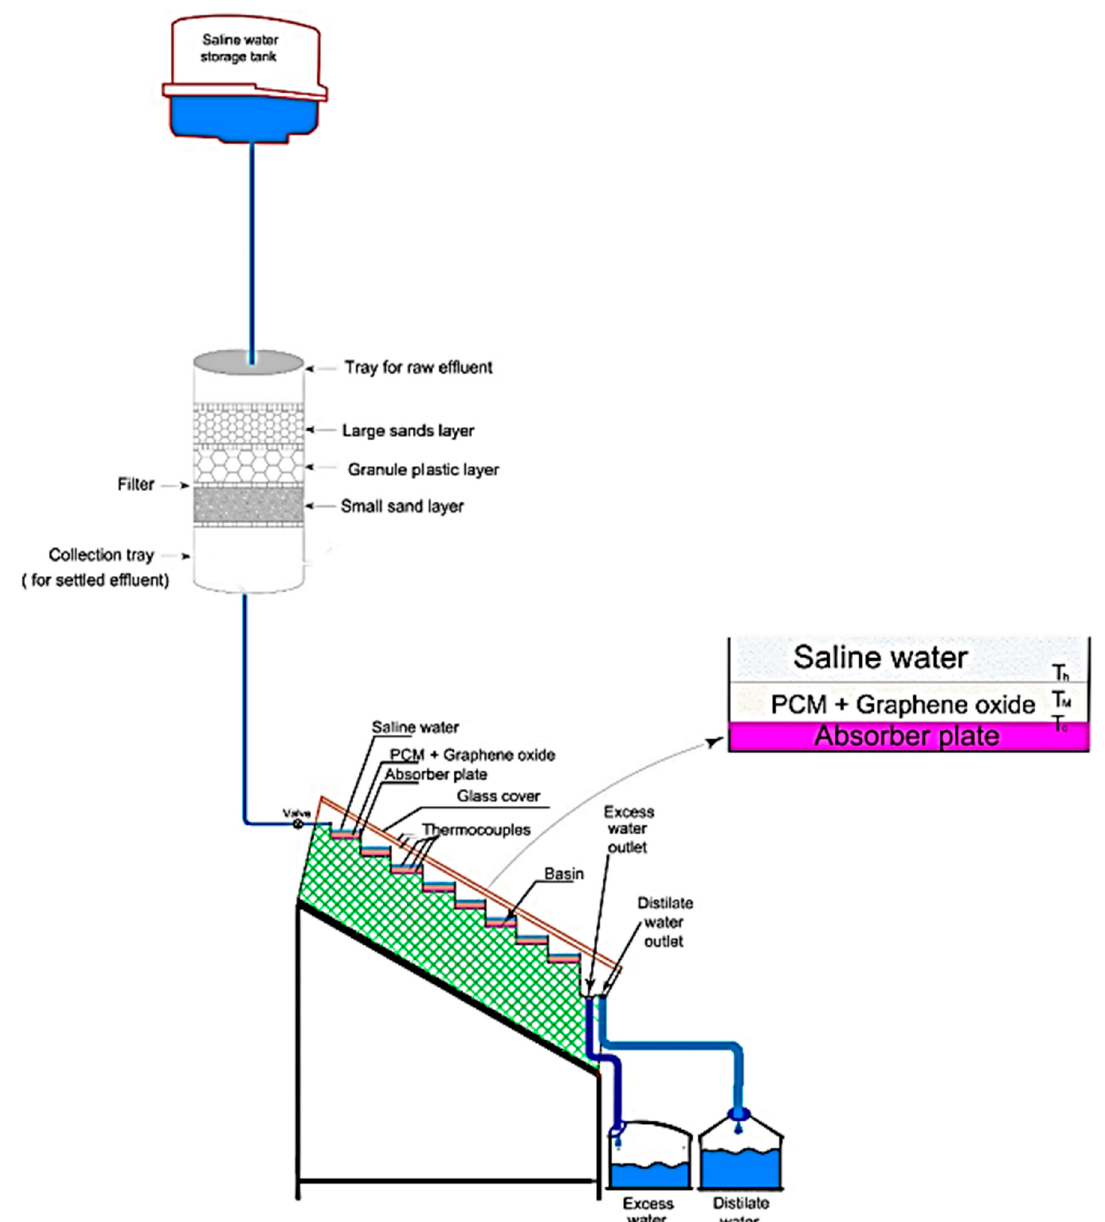
Figure 5. Schematics of utilized solar still.